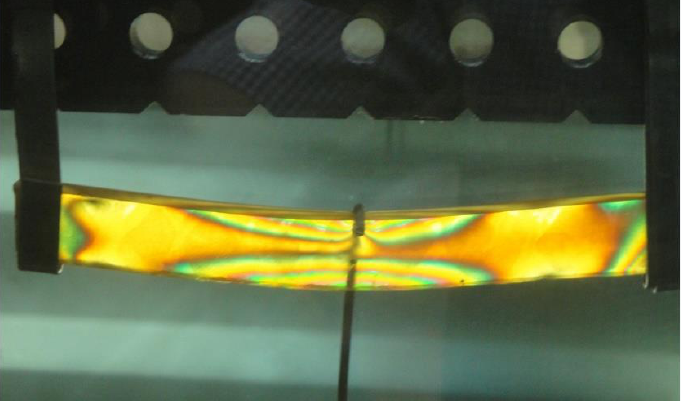
Figure 11. Three bending point test.